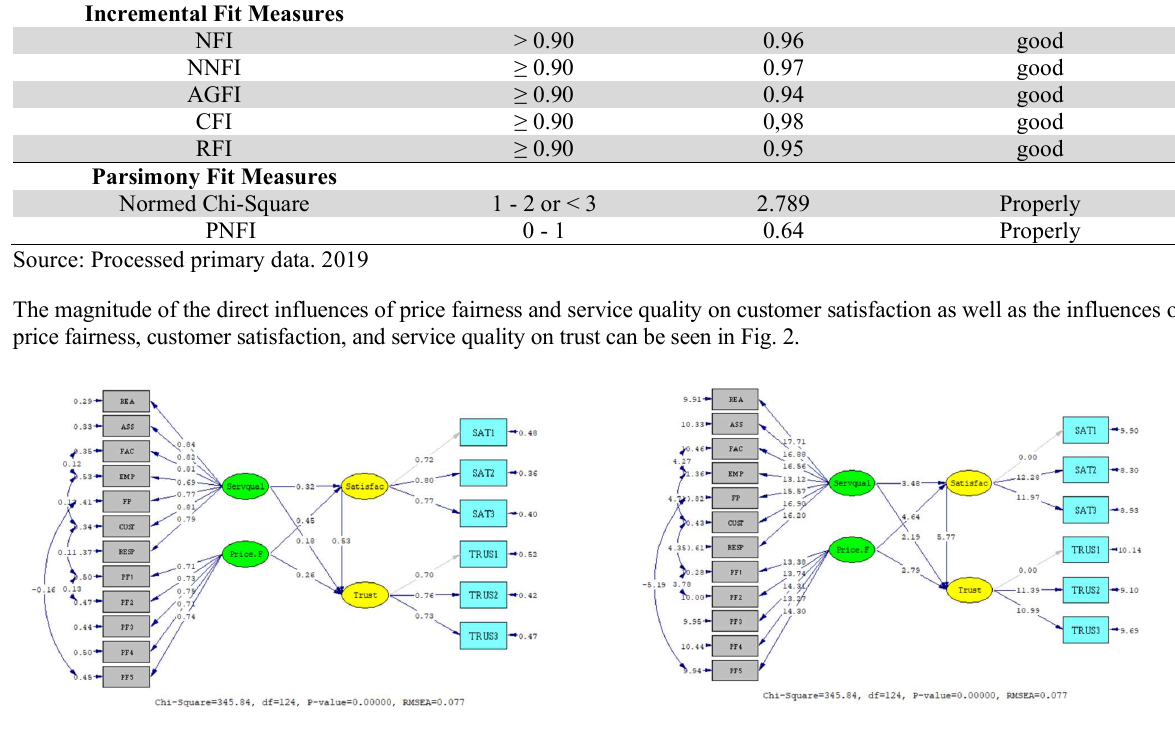
Fig. 2. Final Model (Standardized) Source: Processed primary data.